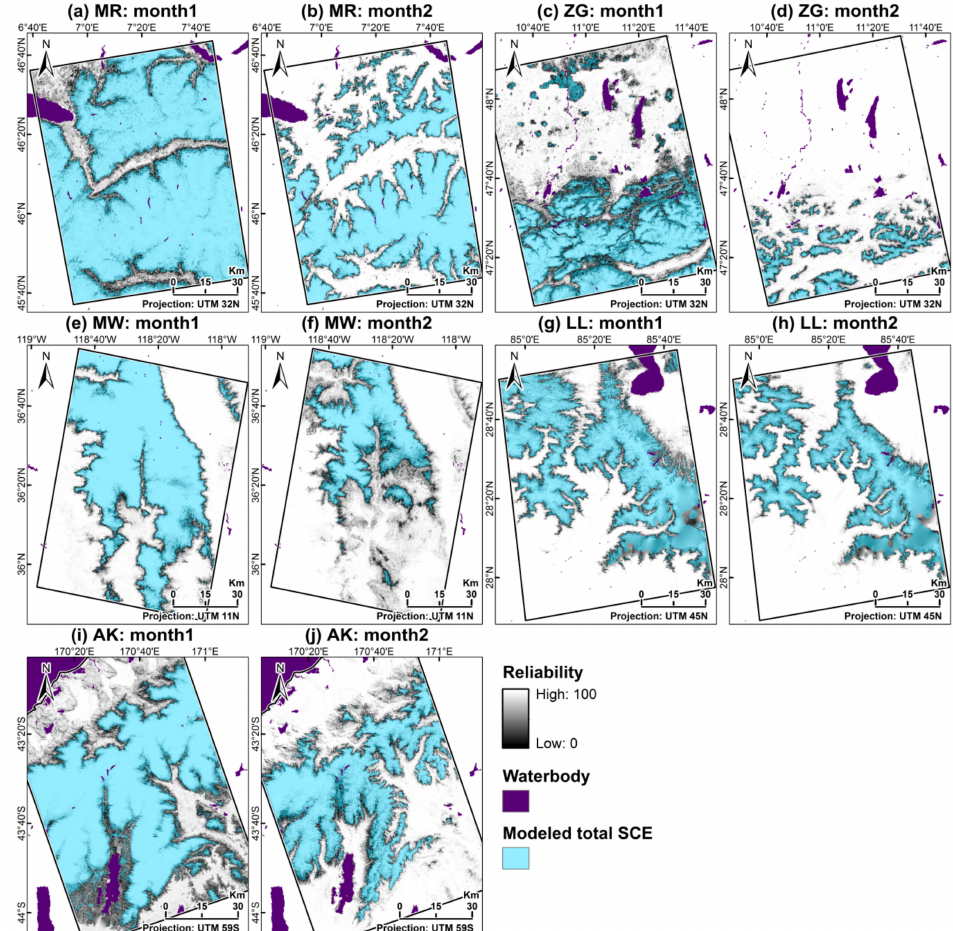
Figure 7. Reliability map with total SCE for two months of each region: ( a ) Monte Rosa (MR), month 1 (Mar 24, 2018); ( b ) Monte Rosa, month 2 (May 23, 2018); ( c ) Zugspitze (ZG), month 1 (Mar 26, 2018); ( d ) Zugspitze, month 2 (May 13, 2018); ( e ) Mount Whitney (MW), month 1 (Mar 16, 2018); ( f ) Mount Whitney, month 2 (May 03, 2018); ( g ) Landtang Lirung (LL), month 1 (Mar 12, 2018); ( h ) Landtang Lirung, month 2 (May 11, 2018); ( i ) Aoraki (AK), month 1 (Jun 30, 2018); ( j ) Aoraki, month 2 (May 01,